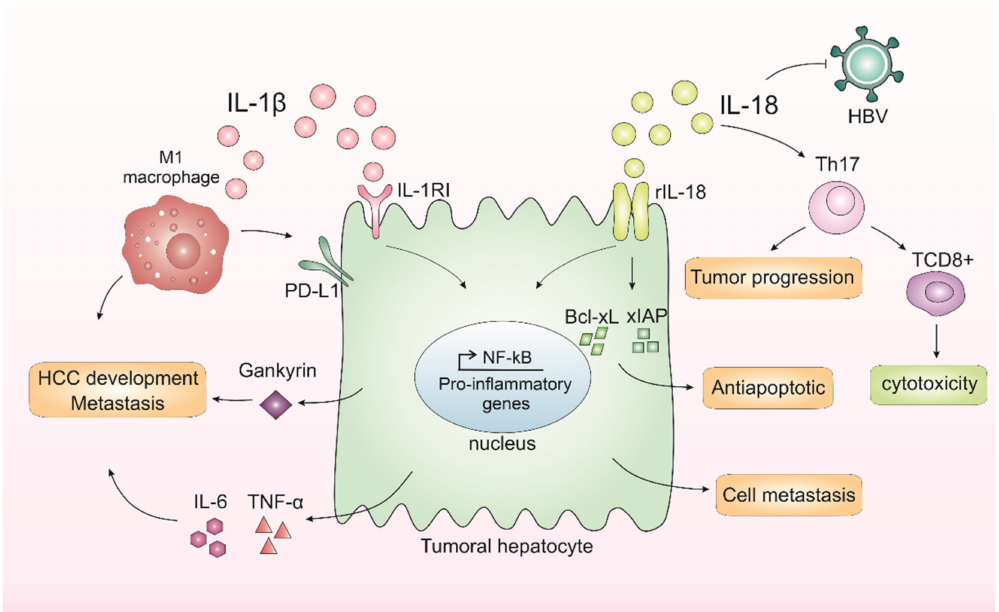
Figure 1. Inflammasomes-mediated cytokines IL-1 β and IL-18 in liver cancer progression. In the liver, IL-1 β leads to the release of IL-6 and TNF- α , cytokines related to a worse prognosis in hepatocellular carcinoma (HCC). IL-1 β binds to interleukin-1 receptor type I (IL-1RI) and, after a series of cascades, activates nuclear factor kappa B (NF- κ B), which in turn is related to proliferation and inflammation. IL-1 β is also capable of promoting the expression of an oncoprotein, Gankyrin, which plays a critical role in HCC development and metastasis. M1 macrophages induce the expression of programmed death ligand 1 (PD-L1) in HCC cells through IL-1 β , supporting the pro-tumor role of M1 macrophages and IL-1 β . IL-18 receptor (rIL-18) is capable of increasing NF- κ B activation and anti-apoptotic molecule expression, including Bcl-xL and xIAP. IL-18 can also regulate Th17 cells, which can both worsen prognosis or affect antitumor cytotoxicity by CD8 + T-cells. Finally, IL-18 could inhibit HBV replication but could also promote hepatocyte cell metastasis and